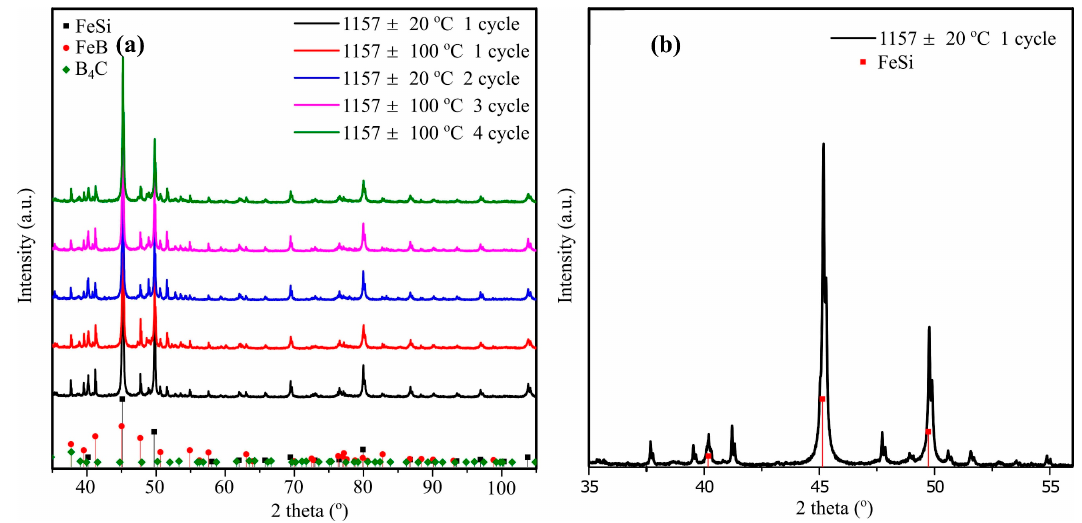
Figure 12. ( a ) XRD patterns of Fe-26.38Si-9.35B alloys with different temperature intervals and thermal cycles. ( b ) An expanded view of the FeSi XRD spectra at the scan range of 35–55°, showing a clear peak shift towards